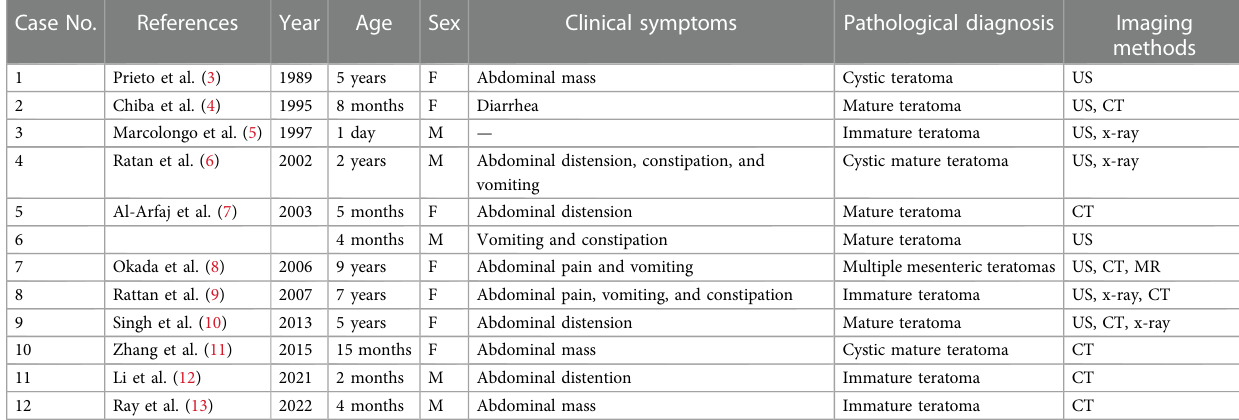
TABLE 2 The 12 cases of mesenteric teratomas previously reported in children. Case